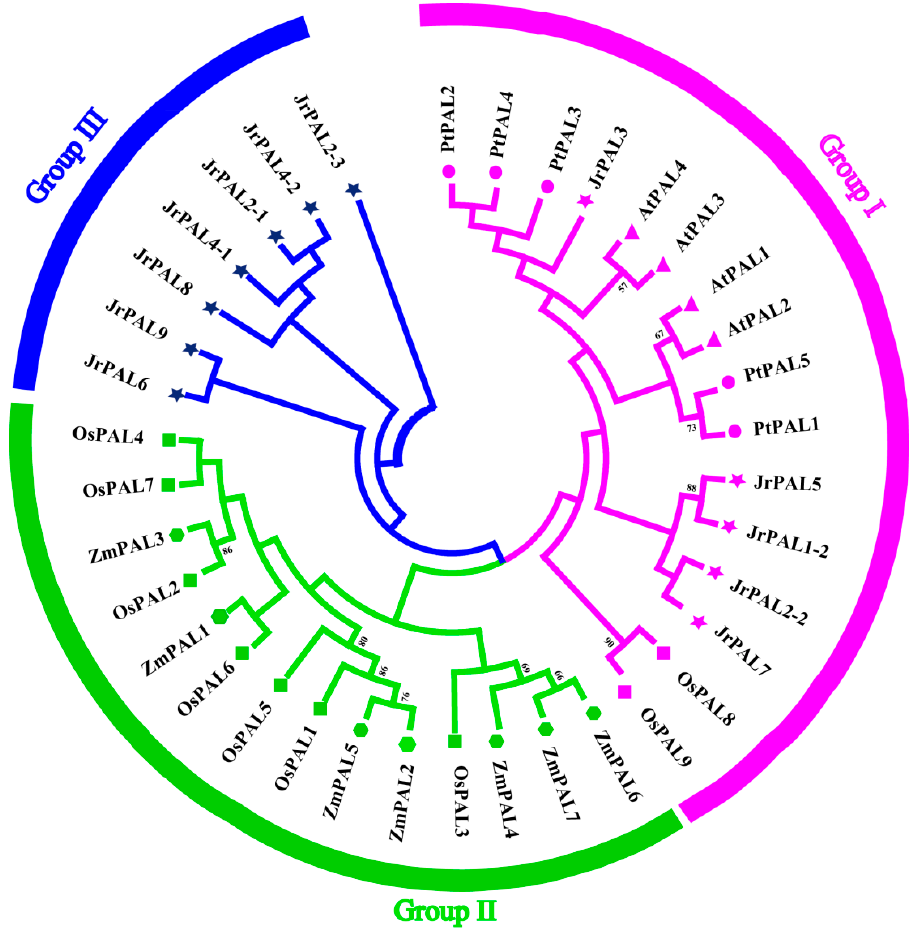
Figure 1. Phylogenetic analysis of phenylalanine ammonia-lyase (PAL) proteins among common walnut (12), Arabidopsis (4), rice (7), maize (6), and poplar (5). These 34 sequences were used to construct a neighbor-joining (NJ) tree. The tree was divided into three groups, represented by different colors. Triangles represent Arabidopsis , rectangles represent rice, pentagons represent maize, circles represent poplar, and pentagrams represent walnut. The number on each node of branch indicates the bootstrap support value more than 50.